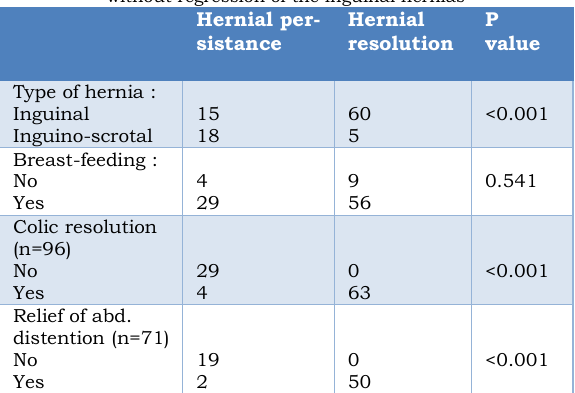
Hernial resolution 60 5